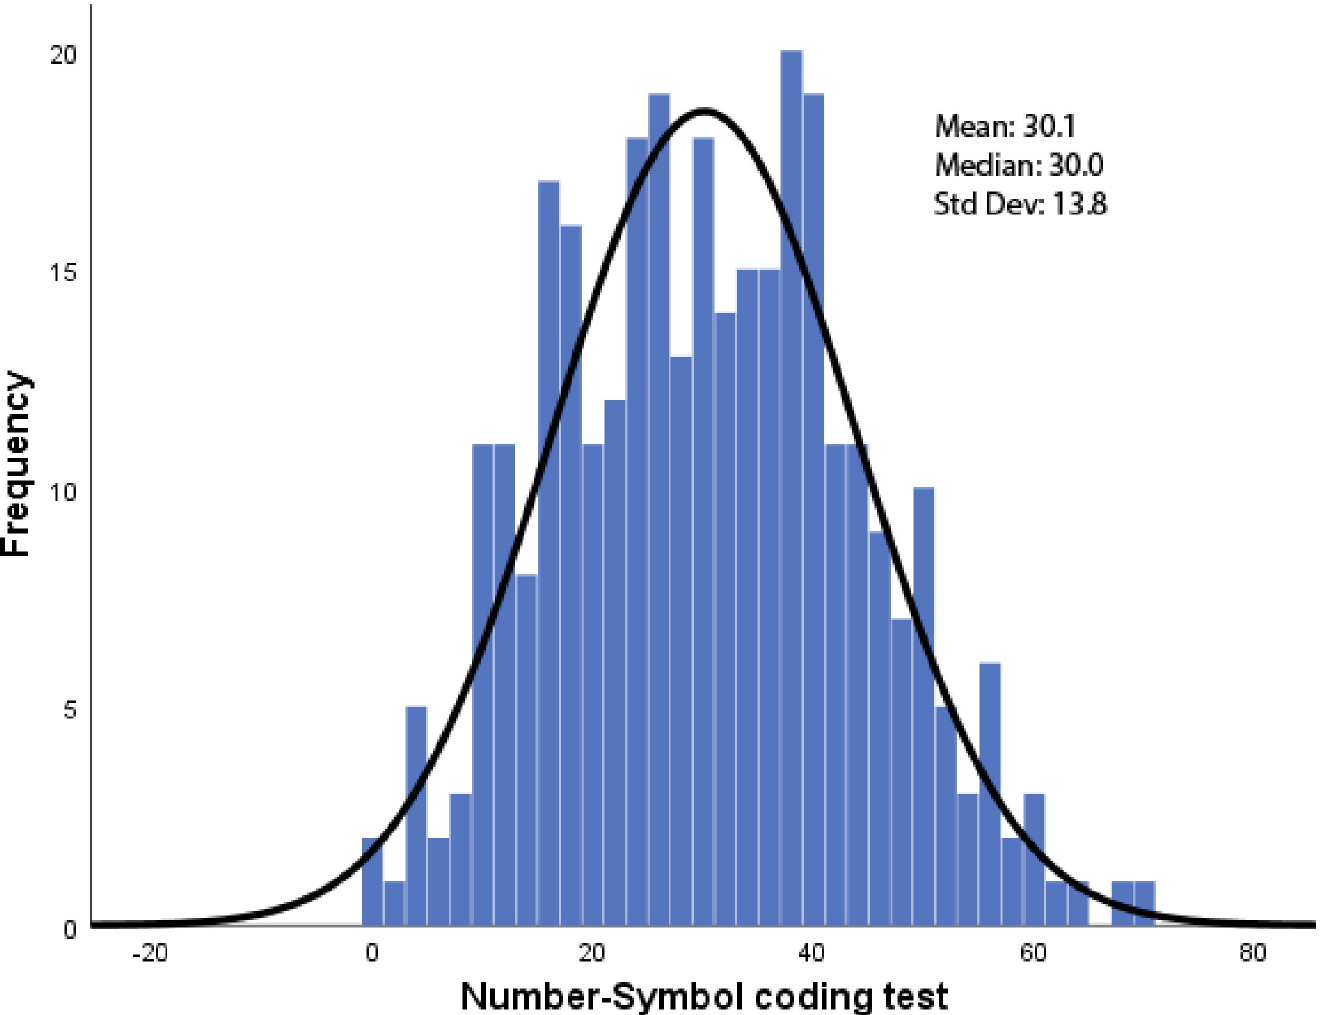
Fig 2. Histogram of Number Symbol Coding Task. This histogram demonstrates that the Number Symbol Coding Task follows a normal distribution with a mean of 30.1, standard deviation of 13.8, and a median of 30.